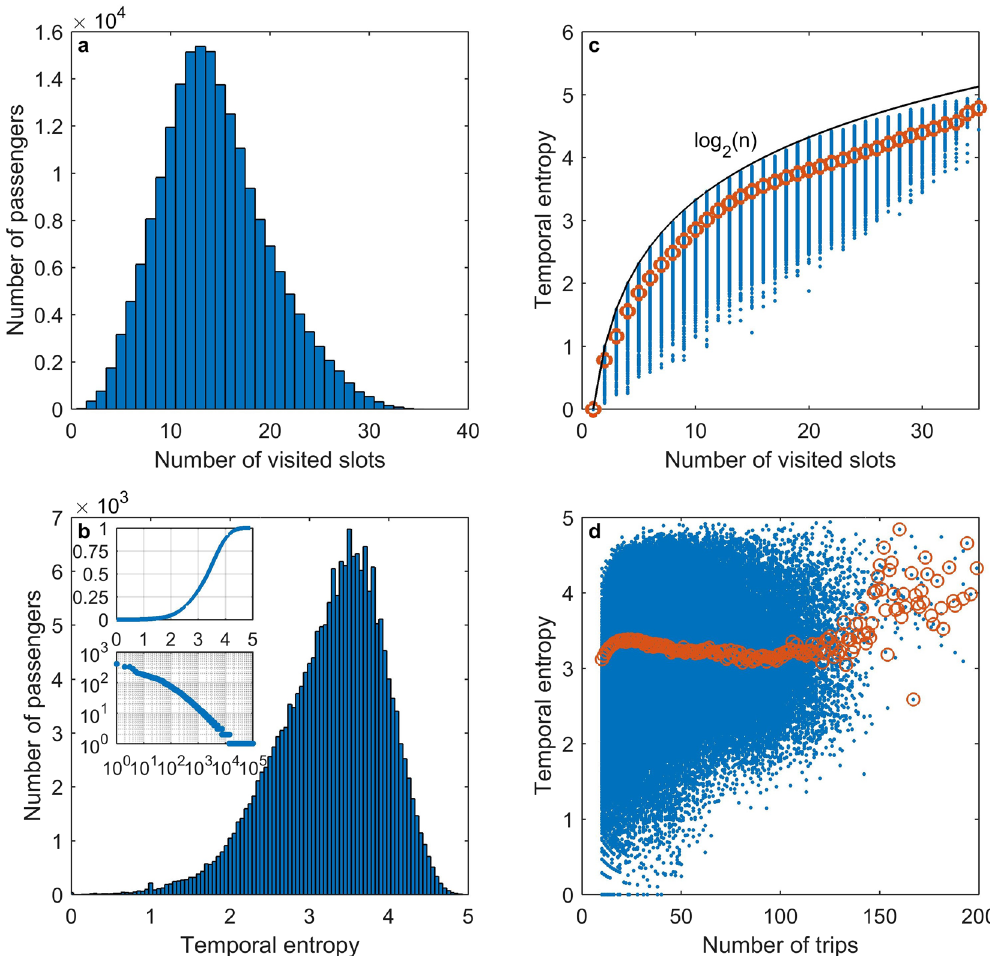
Figure 4. Temporal entropy and its distribution. ( a ) Each bar illustrates the number of passengers who visited a specific number of time slots with a grid size of 30 minutes. ( b ) The histogram of bin width 0.05 illustrates the distribution of temporal entropy. The cumulative frequency distribution is presented in the upper subplot. The log-log graph in the lower subplot shows temporal transit patterns in descending order according to their counts in the entire population. ( c ) The dependence of temporal entropy on the number of visited time slots is illustrated with a theoretical upper bound of log 2 ( n ). Each dot represents an individual. The circles represent the average entropies regarding each specific number of visited stops. ( d ) The dependence of temporal entropy on the number of trips. Each dot represents an individual. Each circle represents the average temporal entropy of individuals sharing a specific number of trips. For conciseness, a few outliers are not presented in the